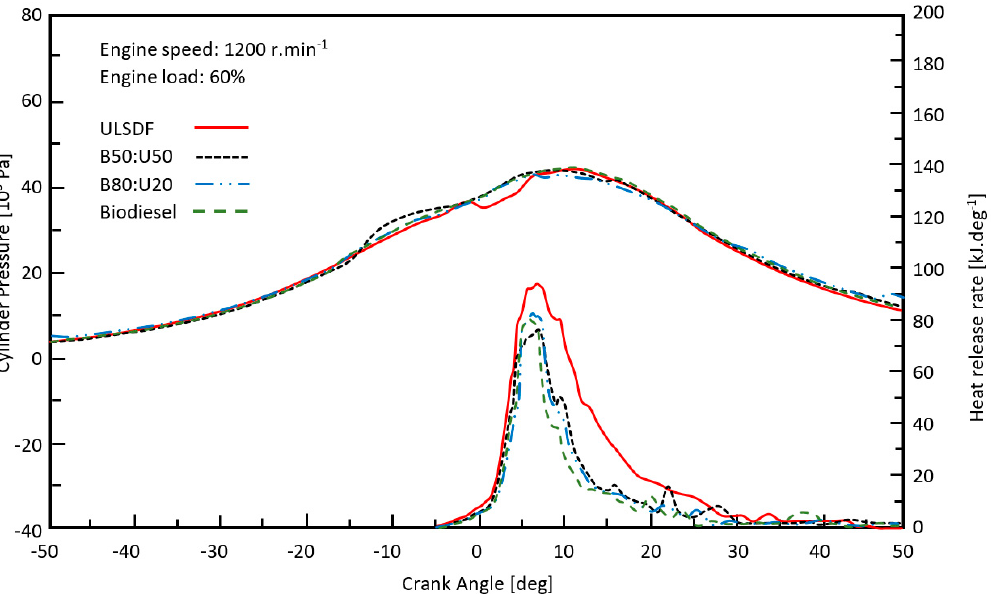
Figure 3. Tested fuels’ influence on the heat release rate and cylinder pressure at 1200 rpm and 60% load .